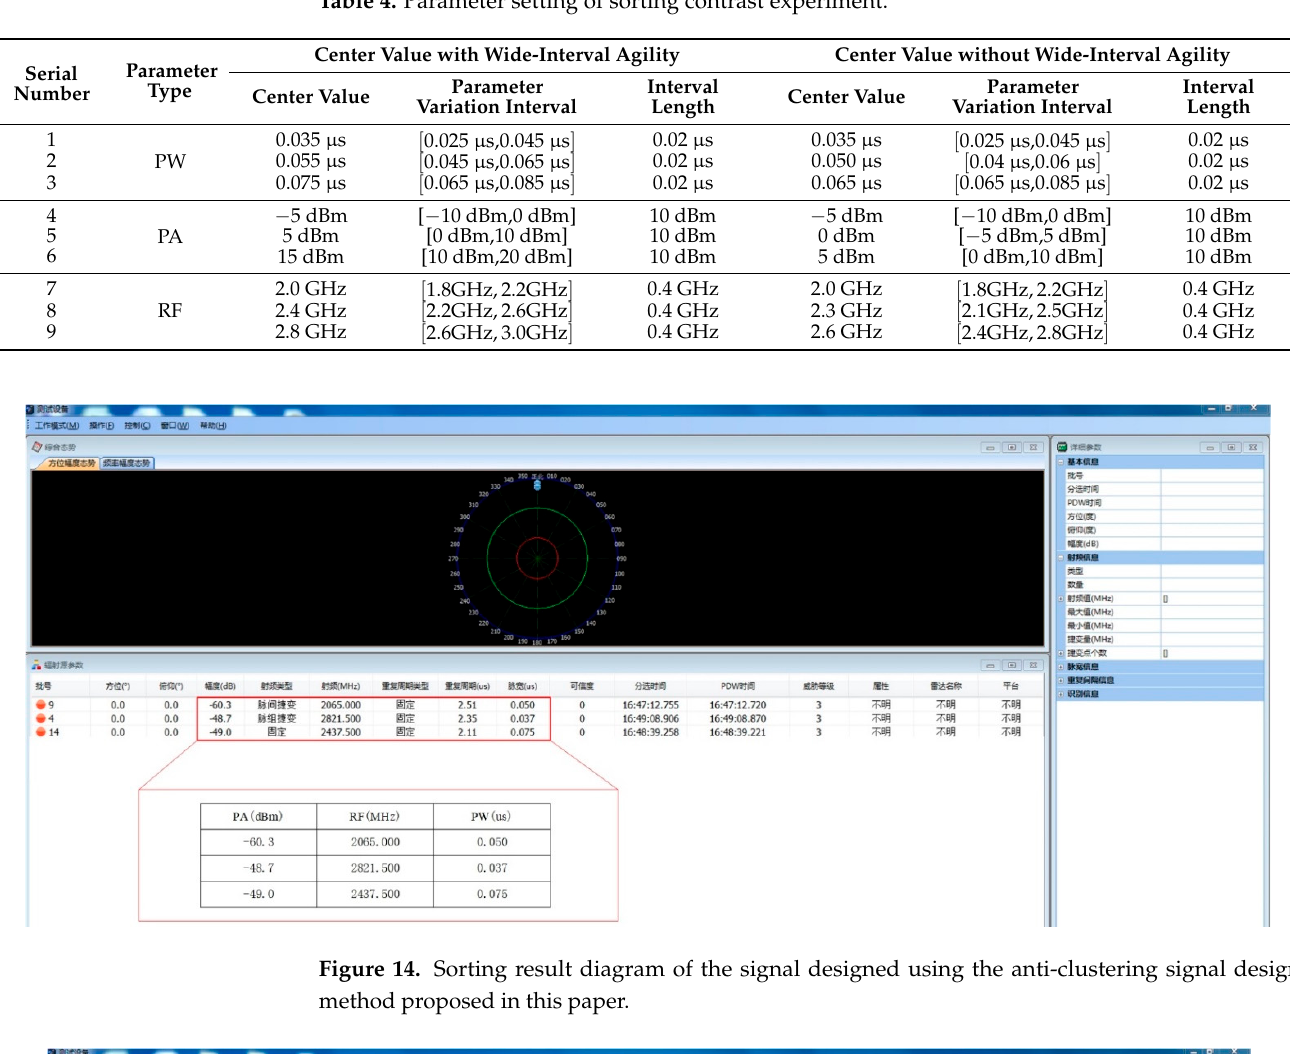
Table 4. Parameter setting of sorting contrast experiment.